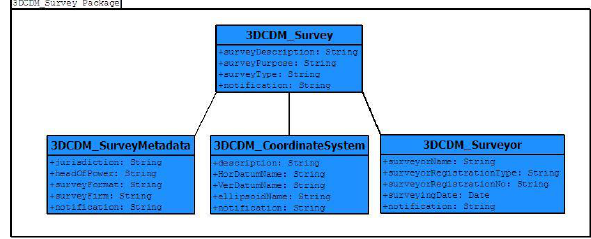
Figure 11. 3DCDM_Survey Package